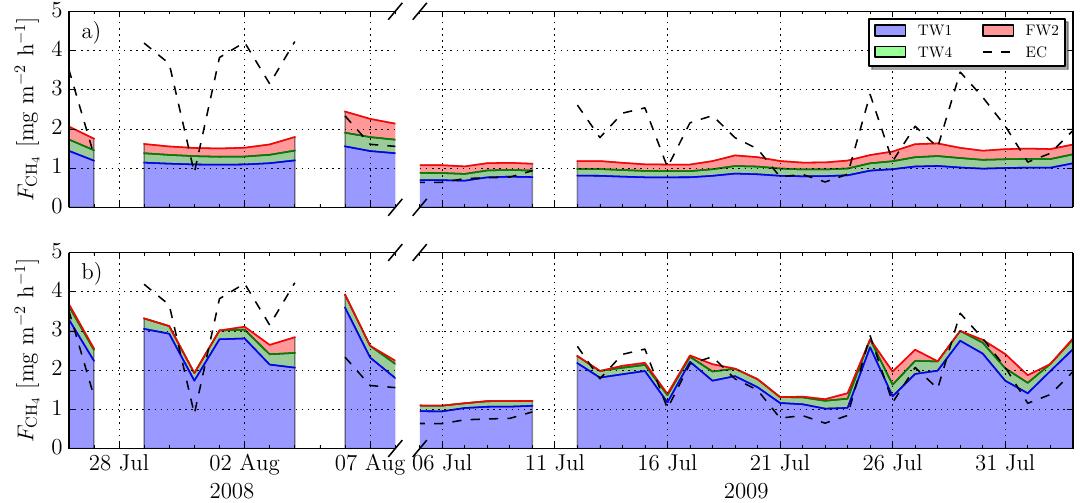
Figure 10. Temporal dynamics of the methane fluxes as measured by the EC system (dashed black lines) and the calculated fluxes of the PEATLAND-VU model using (a) the AW and (b) FW approaches for each class during 2008 and 2009. Contributions from TD1 as well as the River and Lakes class are not shown as they are very close to